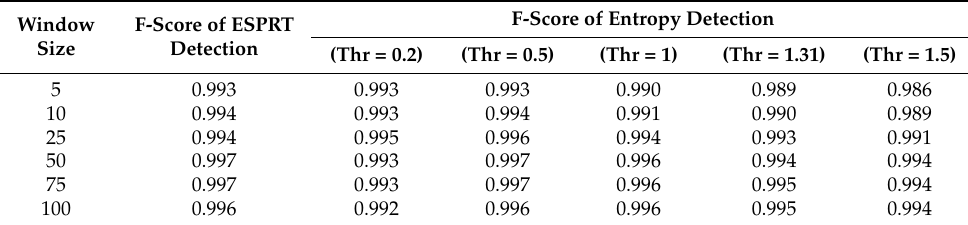
Table 2. F-score of ESPRT and entropy for different window sizes and thresholds.